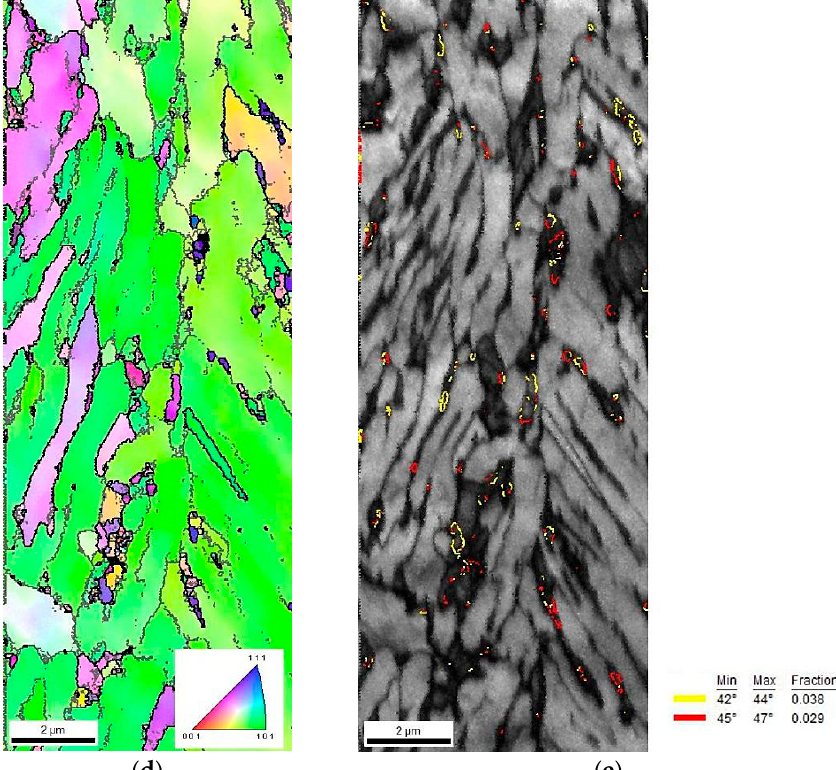
Figure 10. Image of the 3Mn ‐ 1.5Al steel deformed to 10% strain; IQ map ( a ), phase distribution map (retained austenite as red) ( b ), low ‐ angle (2°–15°—thin line) and high ‐ angle (15°–180°—thick line) boundaries map ( c ), inverse pole figure ( d ), grain boundaries of austenite and martensite/bainitic ferrite showing the Kurdjumov–Sachs (yellow) and Nishiyama–Wasserman (red) crystallographic relationships ( e ).